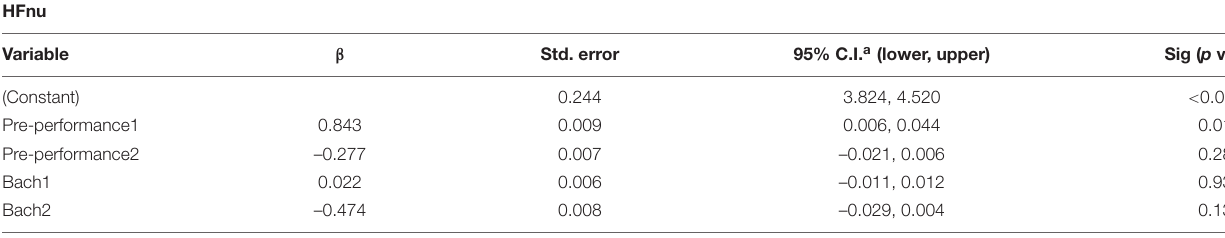
TABLE 6 | Independent association of HFnu with flow during the Bach performance in a multivariable linear regression. HFnu